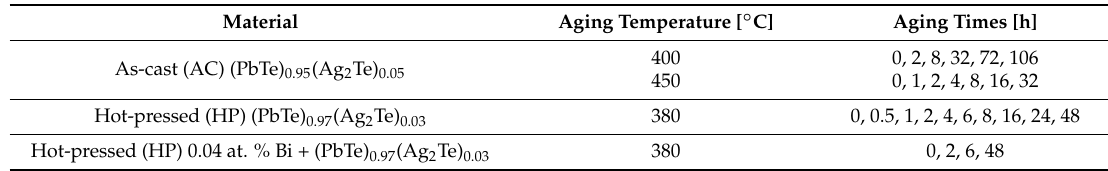
Table 1. A list of the materials’ compositions, synthesis conditions, and heat treatments carried out for each specimen.